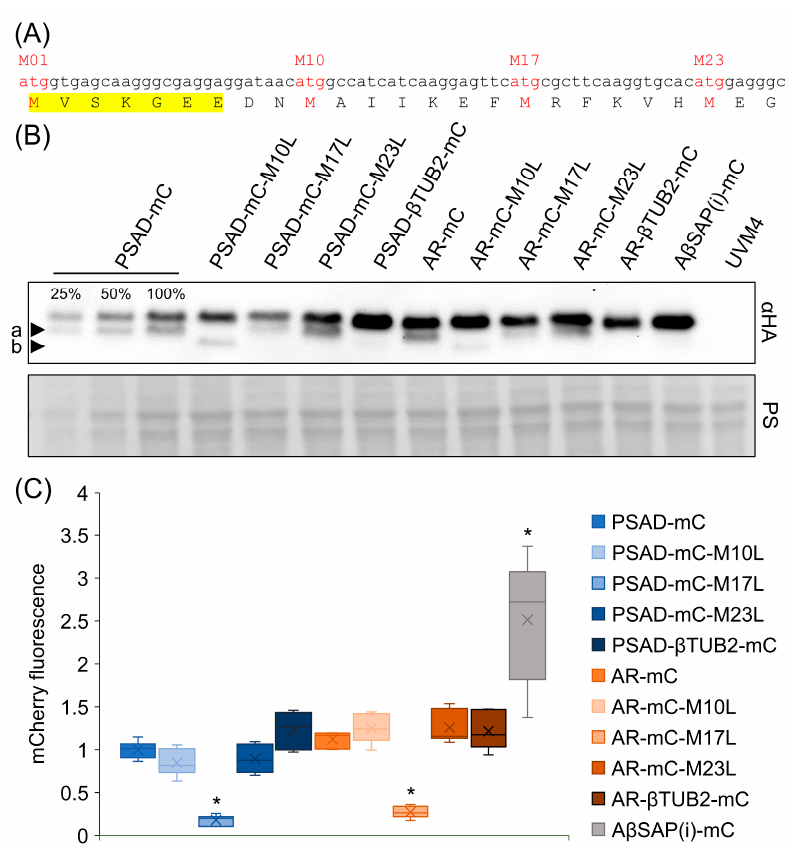
Figure 3. Comparison of the effect of mutated alternative translational start sites and of different 5 ′ -UTRs on the production of mCherry variants. ( A ) Sequence of the 25 N-terminal amino acids of mCherry and the underlying codons. Codons for methionines serving as alternative translation initiation sites are in red letters (M1, M10, M17, M23). The N-terminal fragment derived from eGFP is highlighted in yellow. ( B ) Comparison of mCherry (mC) isoform accumulation in transformant pools. Total cell proteins corresponding to 1 µg chlorophyll were separated by SDS-PAGE and analyzed by immunoblotting using an HA antibody. Alternative translational start codons (M10, M17 or M23) were substituted with codons for leucine (L) in PSAD- and AR-mCherry(i) reporters. In addition, the 5 ′ -UTRs of PSAD and RBCS2 were replaced by that of β TUB2 . Transformant pools containing A β SAP(i)-mCherry(i) and the UVM4 recipient strain were loaded as controls. Ponceau S (PS) staining shows equal loading. Arrowheads a and b point to shorter mCherry isoforms. ( C ) mCherry fluorescence measured in transformant pools normalized to pools generated with the PSAD-mCherry(i) reporter construct ( n = 6). The A β SAP(i)-mCherry(i) fluorescence data from Figure 2C were included for comparison. For significance testing, a one-factor ANOVA was performed using Dunnett’s multiple comparison test against PSAD-mC (*: p < 0.05). Non-significant tests are not shown.